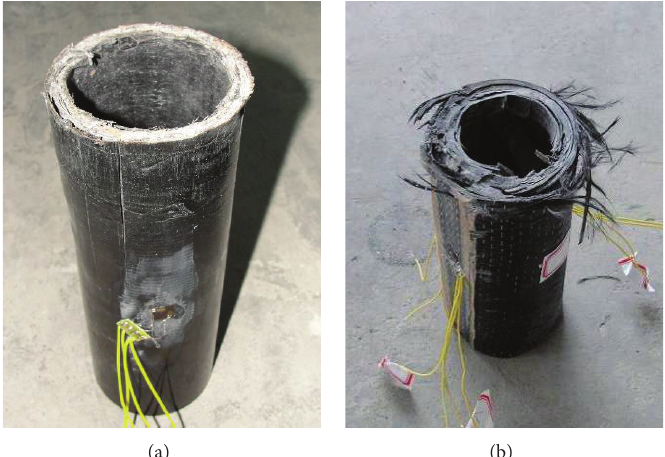
Figure 2: Compressing failed specimens of (a) compressing failed unconfined GFRP short pipe; (b) compressing failed CFRP sheet confined GFRP short pipe.